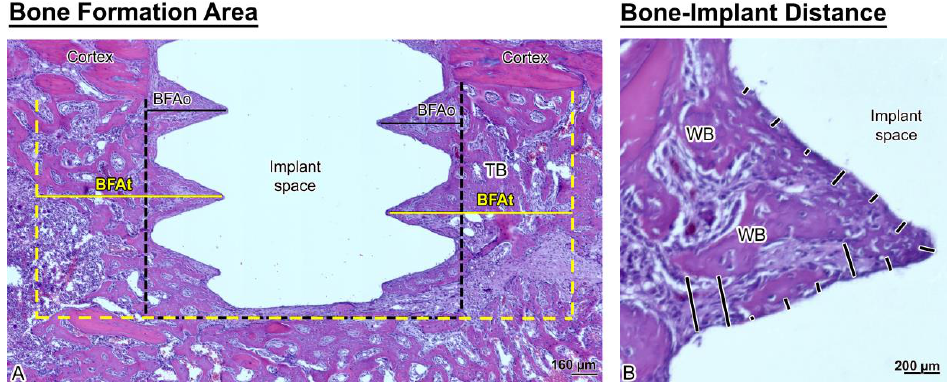
Figure 4. Histological representation of ( A ) bone formation area near the implant (BFAt) (area delimited by the yellow dashed lines) and BFAo (area delimited by the black dashed lines) and ( B ) bone-implant distance (BID) measurements (black lines). Note that the newly formed bone around the implants is trabecular (TB) and woven (WB) in appearance.